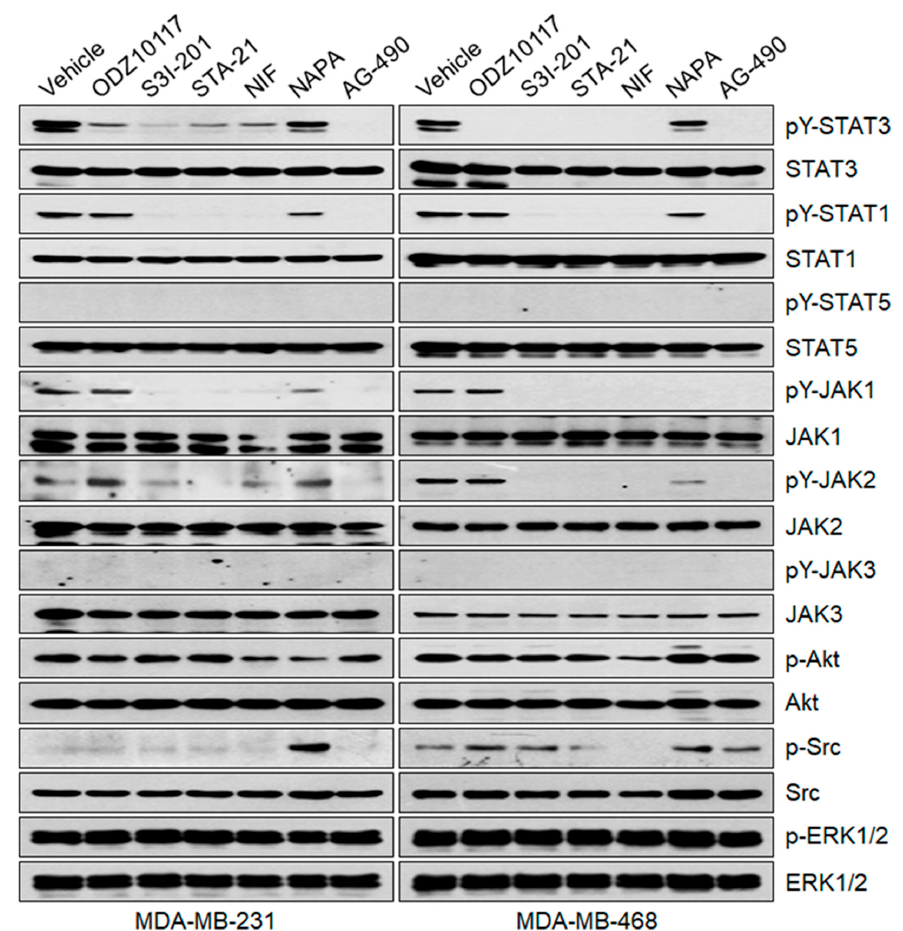
Figure 5. ODZ10117 does not affect other STAT family members and upstream regulators of STAT3. Cells were incubated for 16 h with vehicle (0.1% DMSO) alone, ODZ10117 (ODZ, 40 μ M) or the known STAT3 inhibitors S3I-201 (100 μ M), STA-21 (100 μ M), nifuroxazide (NIF, 100 μ M), napabucasin (NAPA, 4 μ M), or AG-490 (150 μ M), and then performed immunoblot analysis.